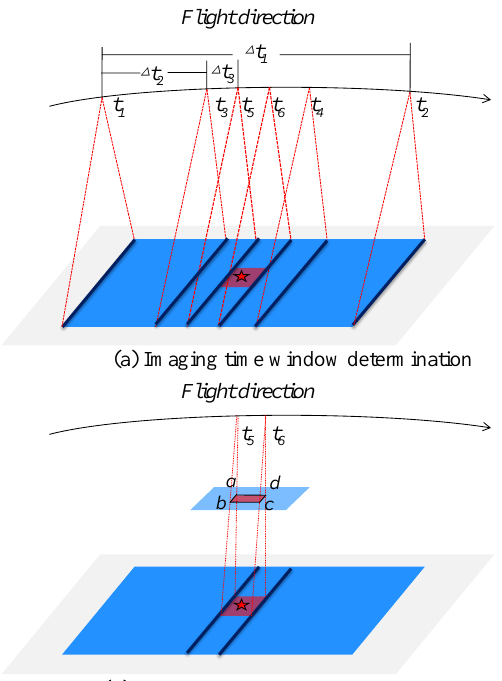
Figure 1. Schematic diagram of imaging time and spatial